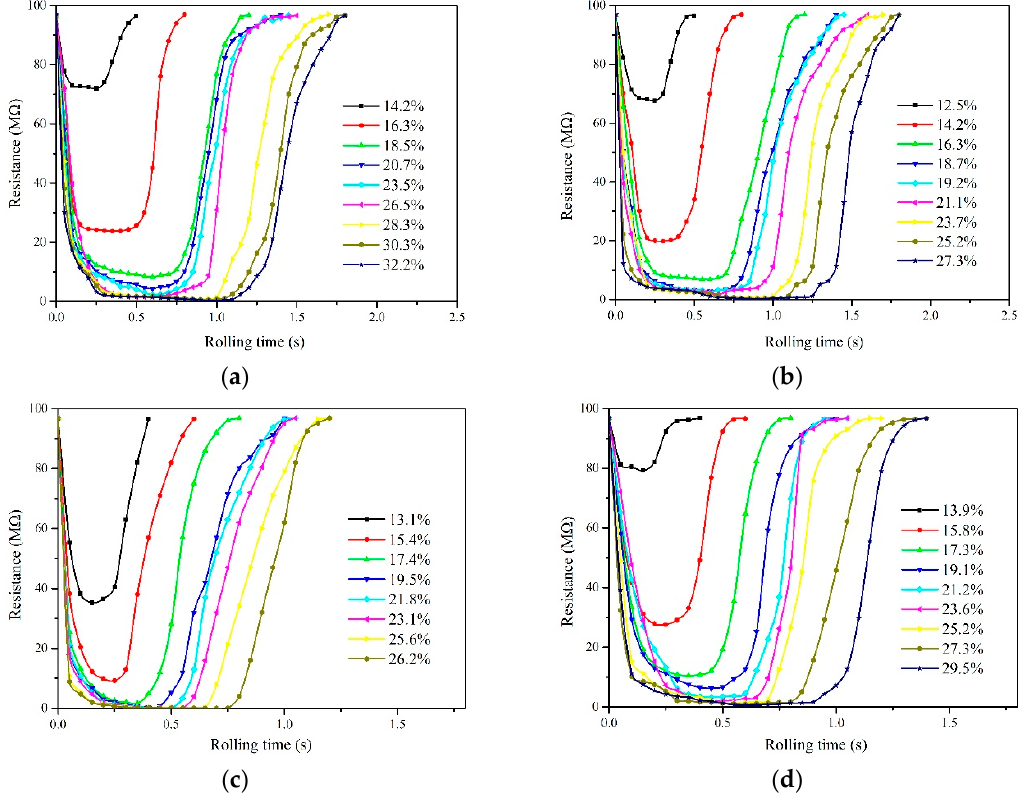
Figure 5. Waveforms of electrical properties of four species in extruding process. ( a ) Xiangzaoxian 45; ( b ) Lumai 21; ( c ) Longpimai 2; ( d ) Nanjing 9108.